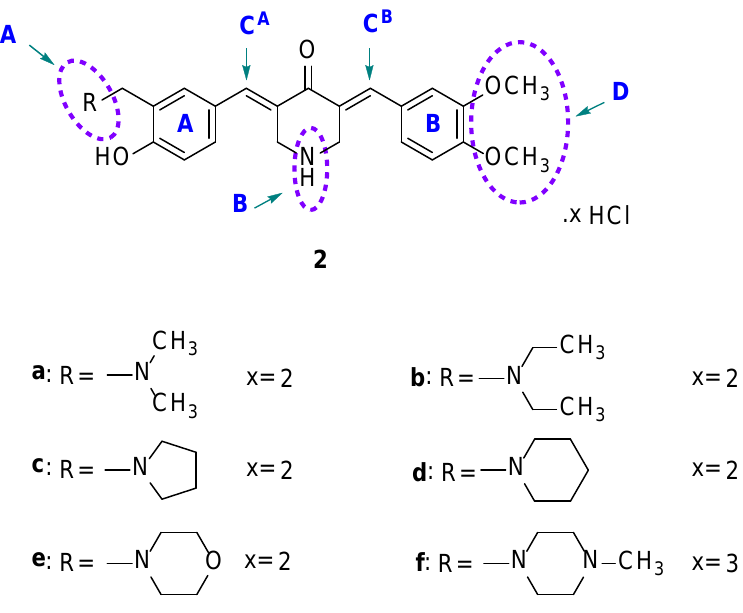
Figure 2. Structures of 2a – f .